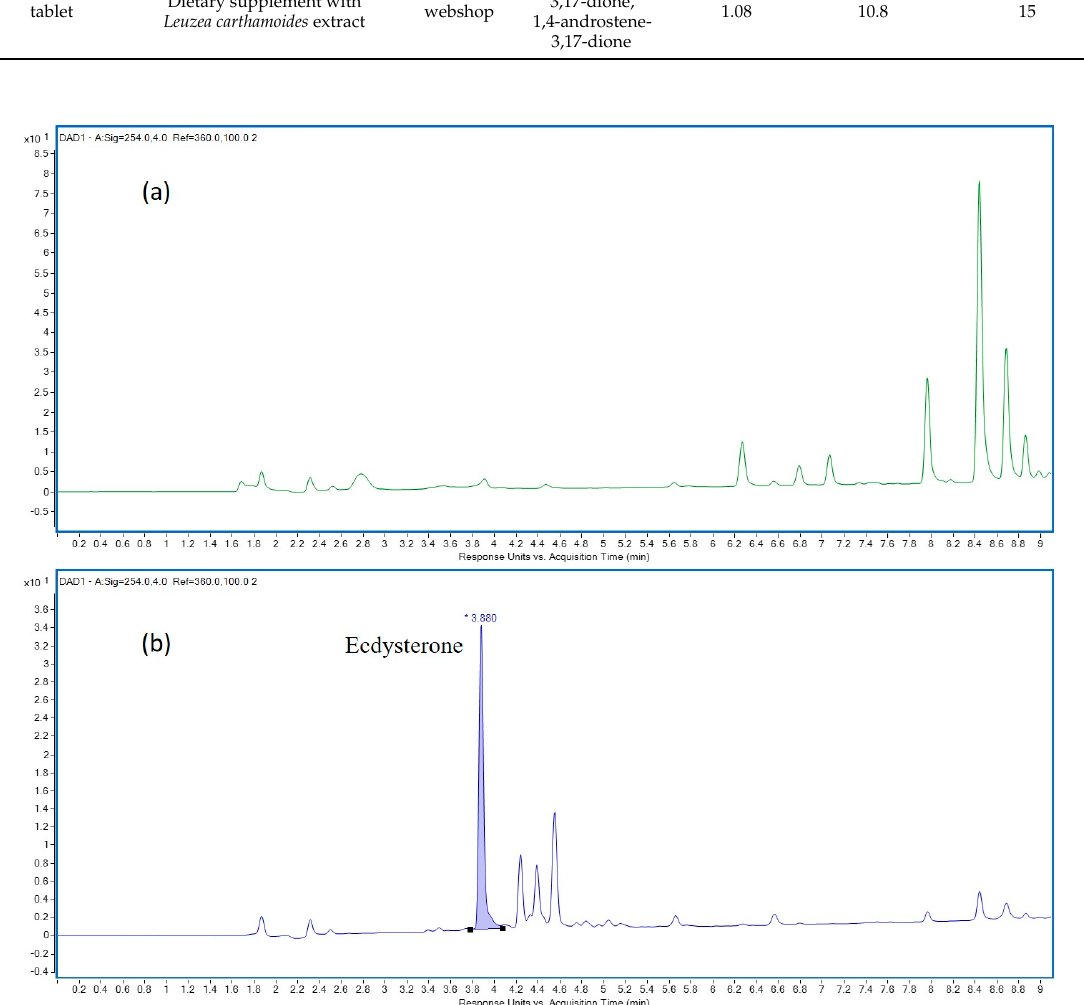
Figure 1. LC-DAD chromatograms of sample (a) “I1” and (b) “I2” detected at 254 nm. RT of ECD is 3.88 min.